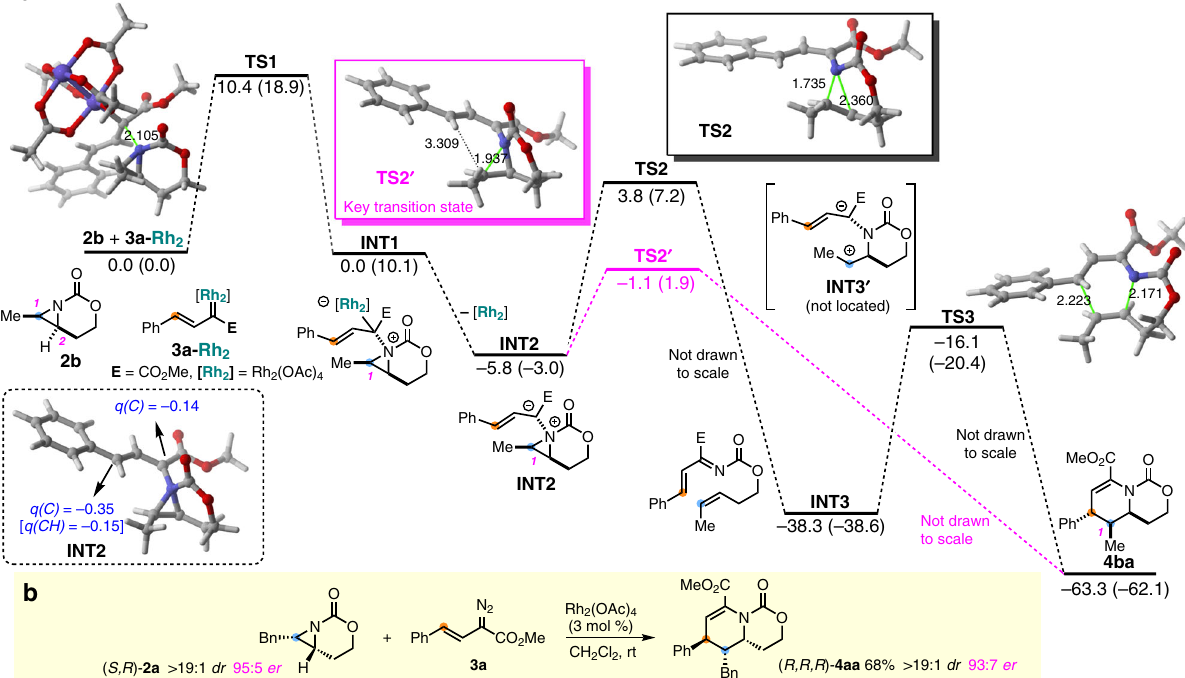
Fig. 3 Mechanistic studies of the [3 + 3] ring expansion. a Computed reaction pro fi le for the process involving 2b and Rh 2 -bound carbene 3a-Rh 2 . Relative free energies ( Δ G, computed at 298.15K and 1 M) and bond distances are in kcal/mol and Å, respectively. All data are computed at the SMD(CH 2 Cl 2 )- B3LYP-D3/def2-SVP level. Values within parentheses are computed at the SMD(CH 2 Cl 2 )-B3LYP-D3/def2-TZVPP//SMD(CH 2 Cl 2 )-B3LYP-D3/def2-SVP level of theory. b Stereochemical retention